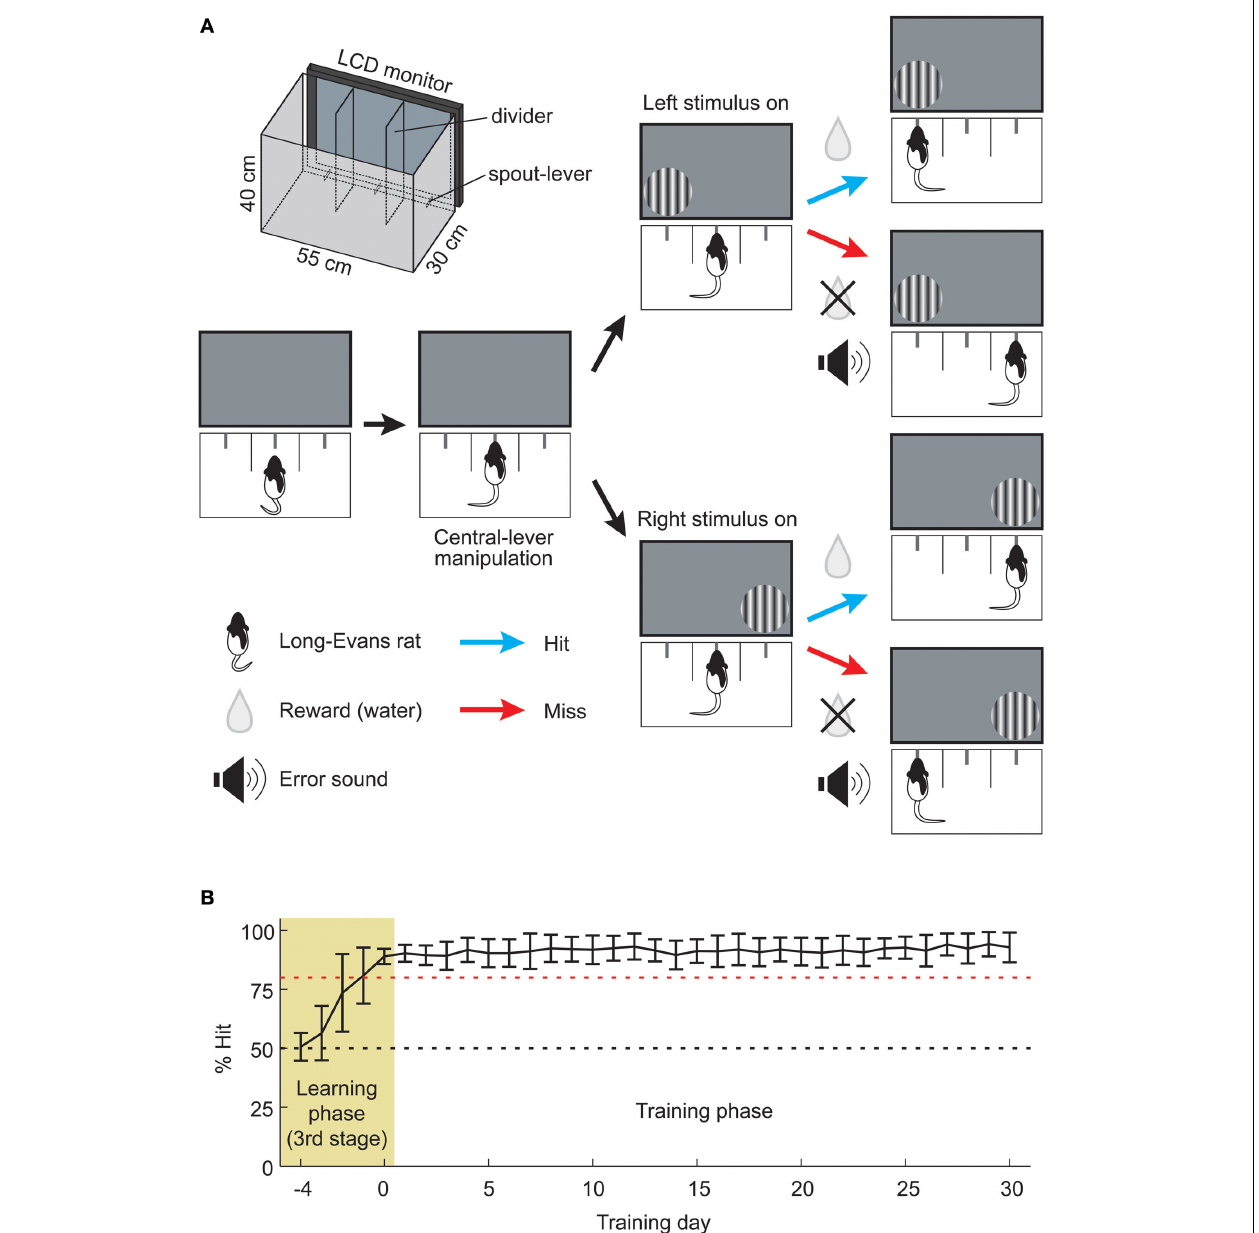
FIGURE 1 | Assessment of well-trained memory by the 2AFC visual detection task. (A) Schema of the visual stimulus detection task based on a 2AFC paradigm. First, the rat pulled central-lever up for presenting the visual stimulus. Next rat was required to detect the stimulus and pull the corresponding choice-lever upward. When the animal made a correct choice (Hit), water was rewarded from the choice-lever. In the case of an incorrect choice (Miss), only an error signal was given. The